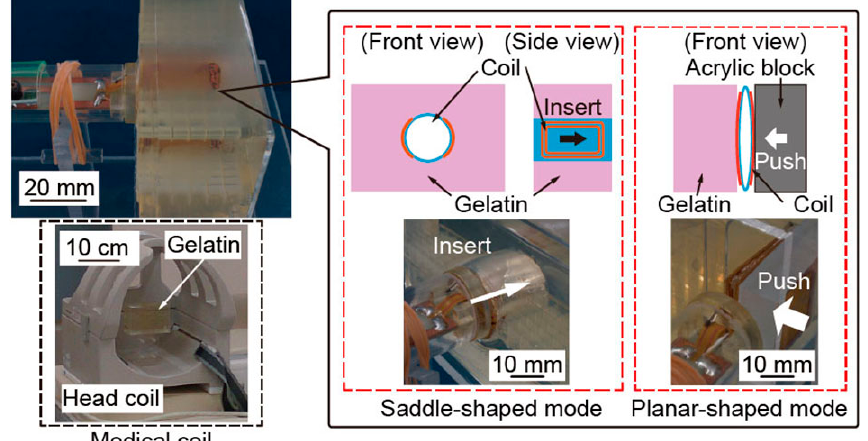
Figure 8. Schematic of the gelatin placement. The micro saddle coil was inserted into the gelatin in saddle-shaped mode, and pushed against the gelatin in planar-shaped mode. The medical head coil is evaluated for comparison.